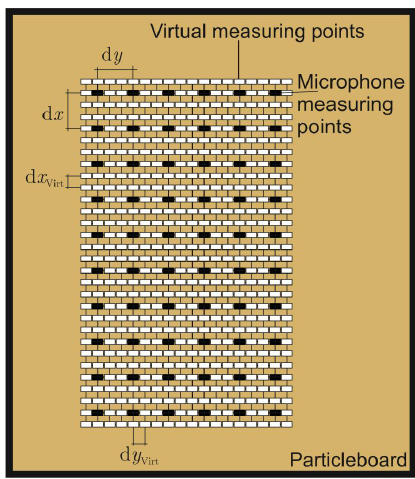
Figure 8. The idea of virtual measuring grid points.